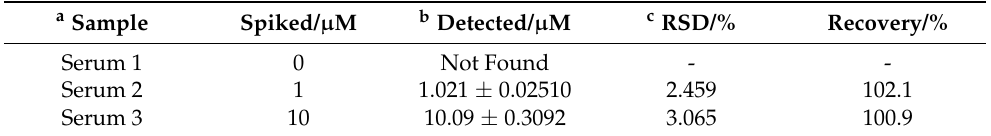
Table 1. Determination of FA in human serum samples using the electrochemical sensor. All experiments were performed six times.